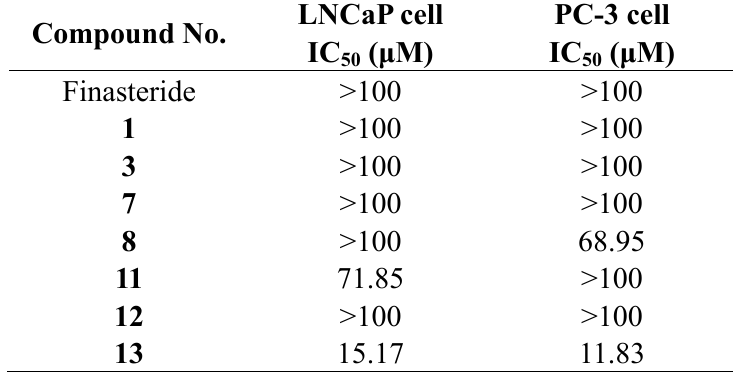
Table 1. The IC values of synthesized compounds on LNCaP and PC-3 50